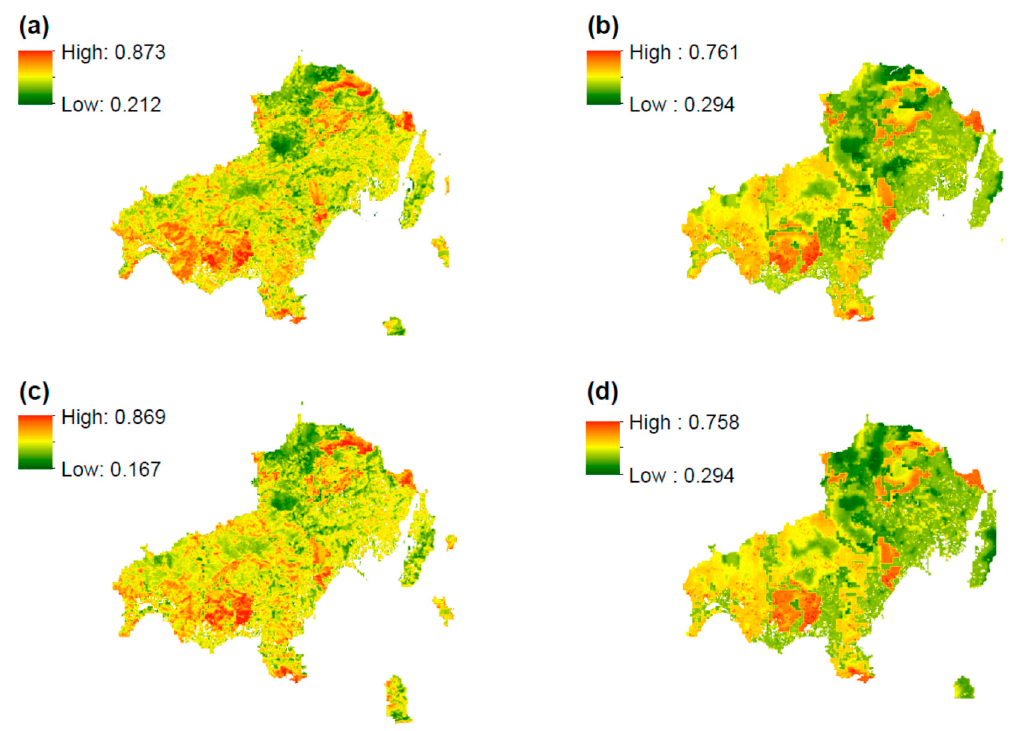
Figure 3. ( a ) AHP-knowledge-based fire hazard map for 1996, ( b ) AHP fuzzy logic fire hazard map for 1996, ( c ) AHP-knowledge-based fire hazard map for 2016, and ( d ) AHP fuzzy logic fire hazard map for 2016.